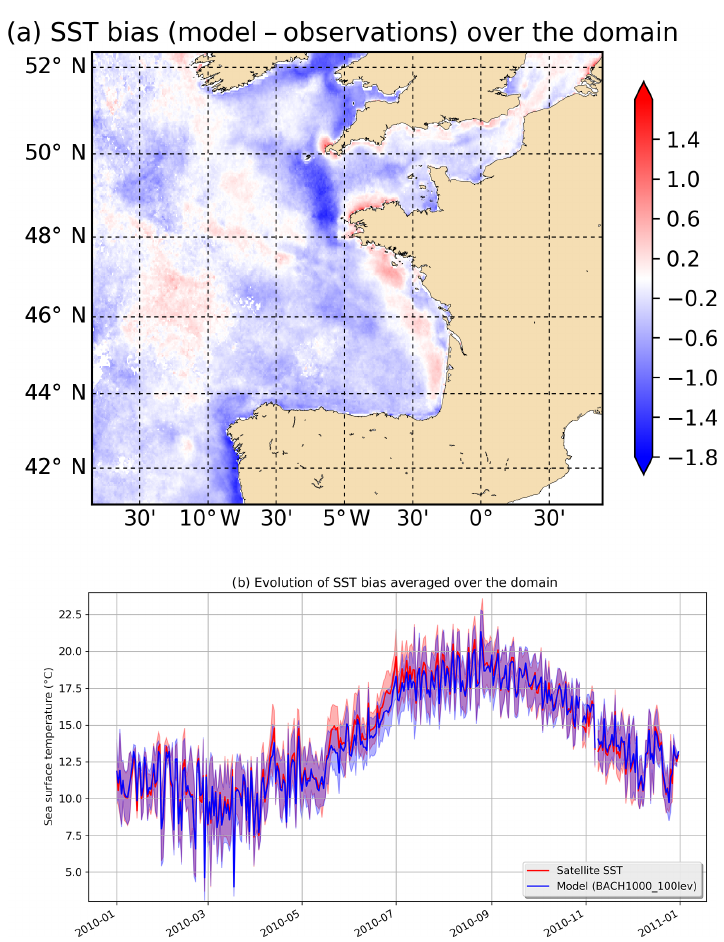
Figure 2. Comparison between observed (SEVIRI satellite SST) and modelled (BACH1000_100lev simulation) sea surface temperature (SST). (a) Mean bias between model and observations for the year 2010. (b) Temporal evolution of the spatial mean SST bias during 2010. The shading around the curves represents the spatial standard deviation (i.e. the standard deviation over the domain computed for each time